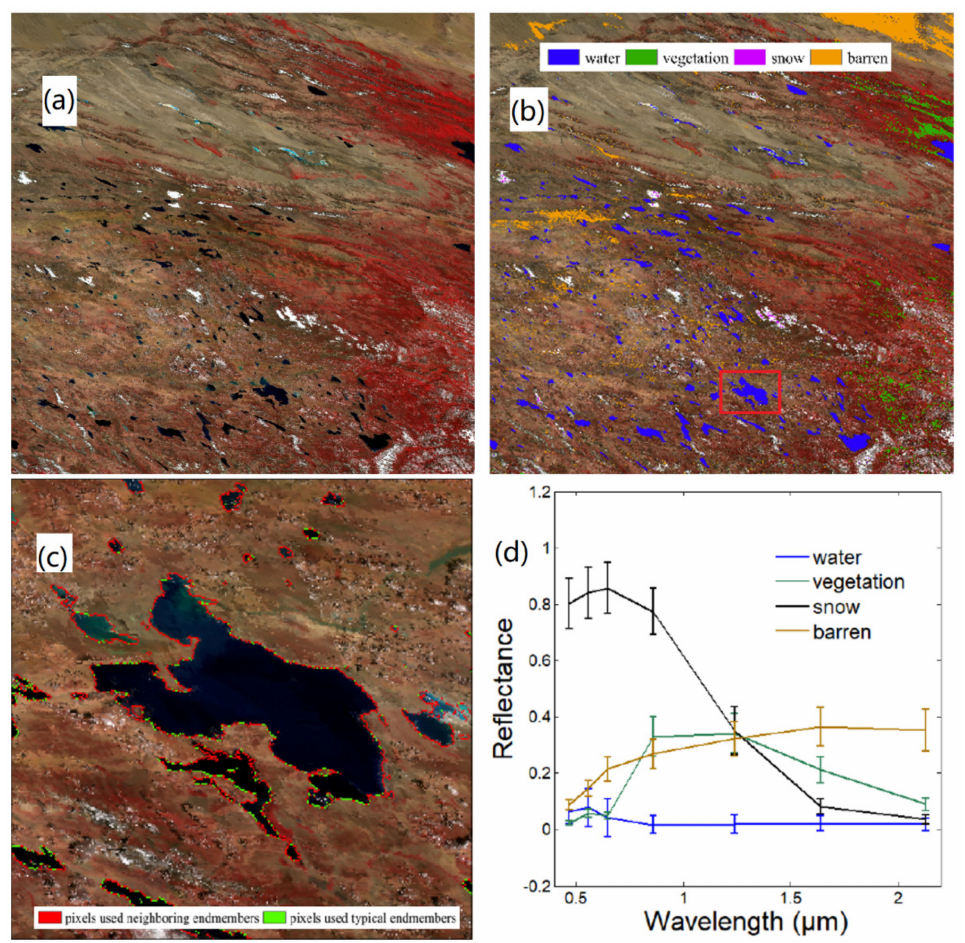
Figure 8. Example of the endmember selection strategy: ( a ) the false color composite MOD09A1 imagery (h25v05, DOY: 233–240 in 2014); ( b ) the map of the selected endmembers using the multi-index threshold method; ( c ) the map of the mixed water pixel (Selin Co Lake in the red rectangle in Figure 8b) using neighboring endmembers (red) and typical endmembers (green); ( d ) the typical endmember spectra. Error bar is the standard deviation of the reflectance for each endmember